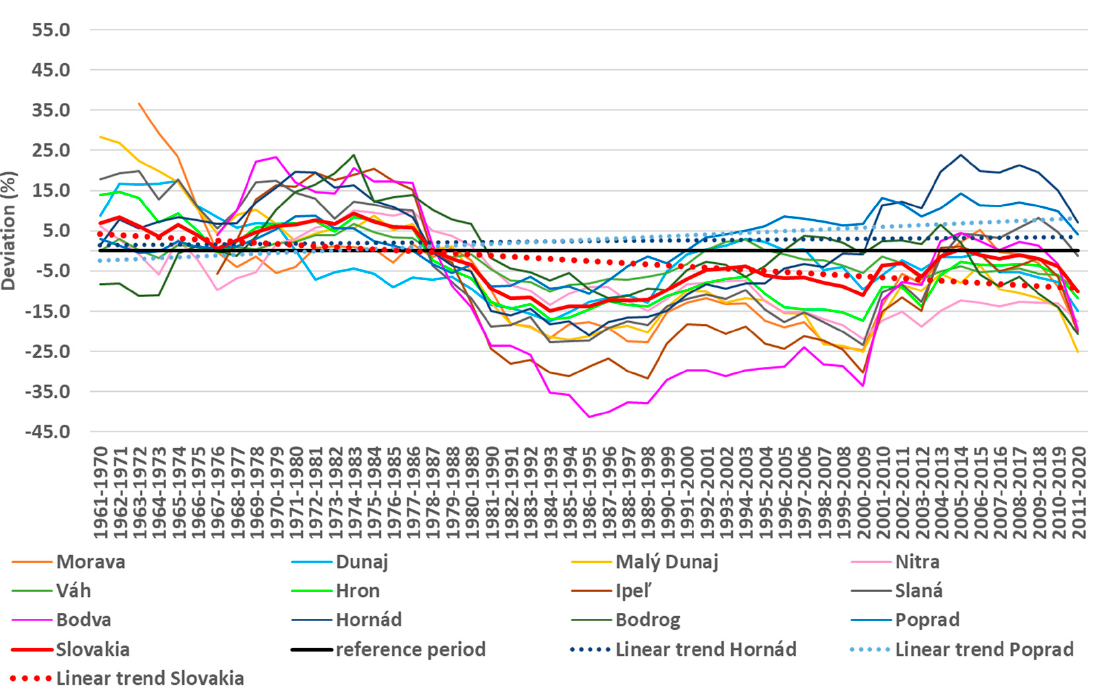
Figure 2. The course of 10-year moving values of the average deviations (%), reference period 1961– 2000.